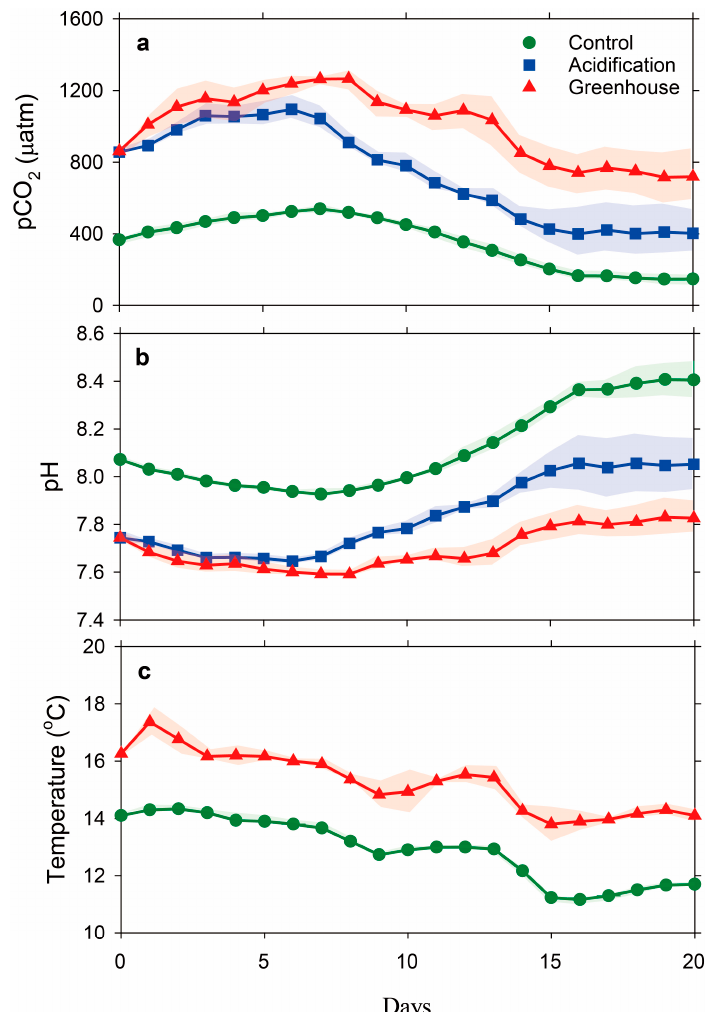
Figure 2. Changes in ( a ) seawater pCO 2 , ( b ) pH, and ( c ) seawater temperature in the control, Figure2. Changesin( a )seawaterpCO 2 ; ( b )pH;and( c )seawatertemperatureinthecontrol,